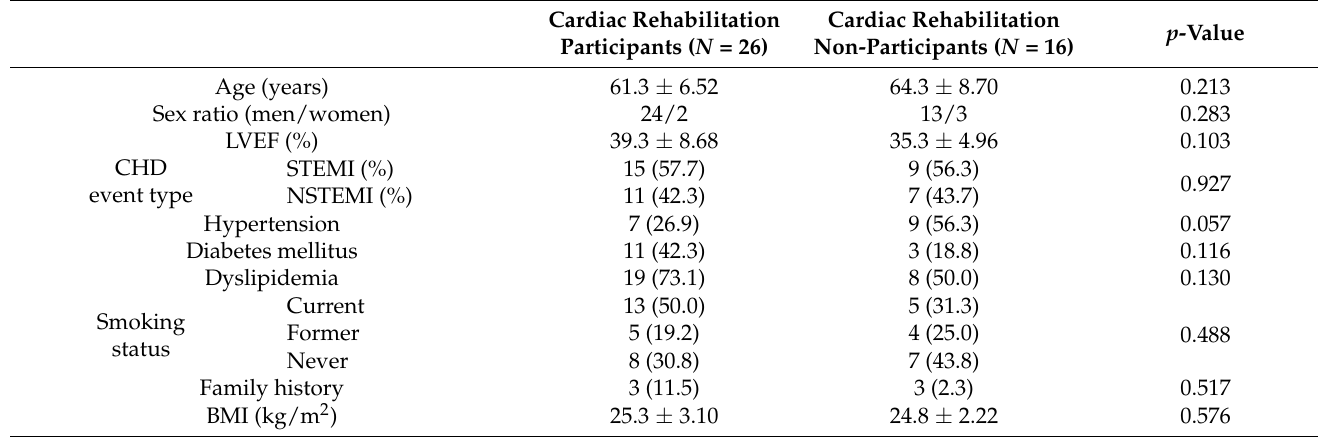
Table 1. Clinical demographic characteristics of the subjects.